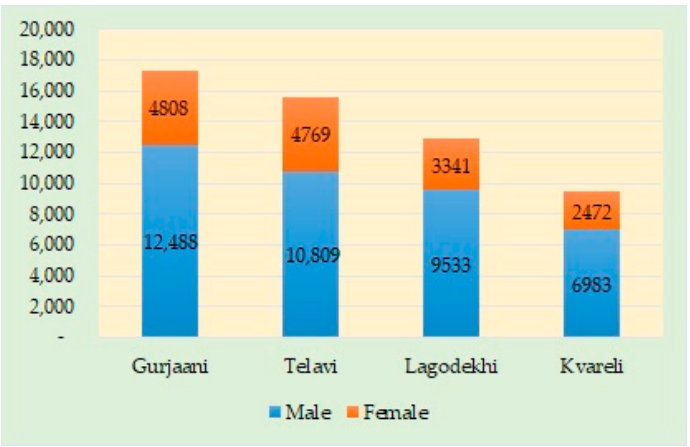
Figure 3. Population in targeted municipalities of Kakheti’s regions (source: Geostat, census 2014).